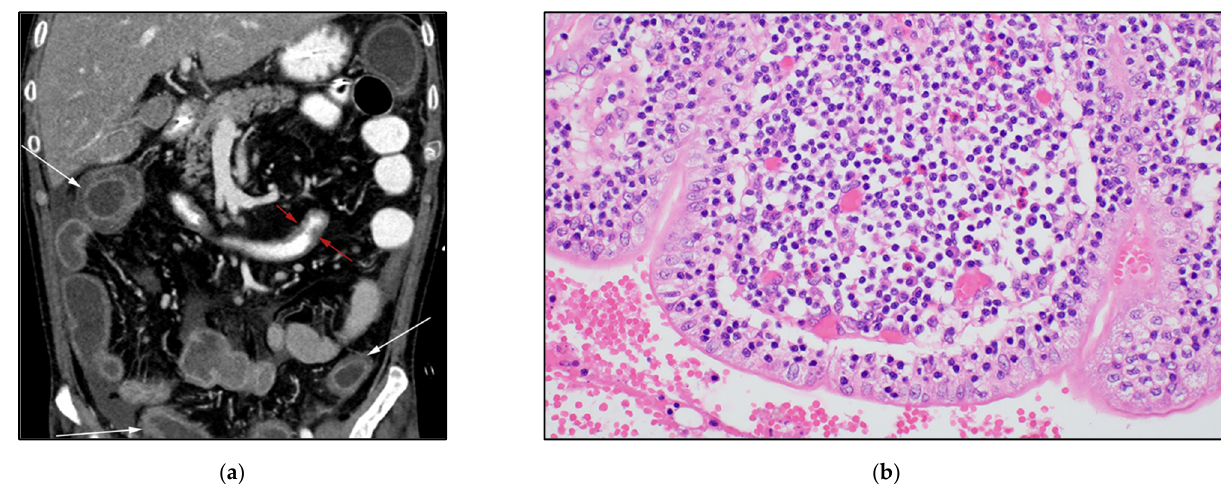
Figure 9. 60-year-old-male with known diagnosis of Crohn’s disease, presenting with refractory symptoms in the form of abdominal pain, watery diarrhea and weight loss ( a ) Coronal CECT images show extensive thickening of the large and small bowel in the form of submucosal edema and mucosal enhancement (white arrows). Additionally, note mucosal polypoidal thickening of the proximal jejunal bowel loops (red arrows). Patient underwent endoscopy and biopsy of jejunal bowel loops, revealing primary T-cell lymphoma of the bowel. ( b ) The histologic section discloses type II EATL from a patient presenting with an intestinal lymphoma with villous blunting and goblet cell depletion, with atypical intraepithelial lymphocytes showing prominent epitheliotropism. Note the monotonous population of medium-sized lymphoid cells with slightly dispersed chromatin, inconspicuous nucleoli and ample clear cytoplasm, imparting a monocytoid appearance in the submucosa. (Original magnification 400 ×, H&E stain)